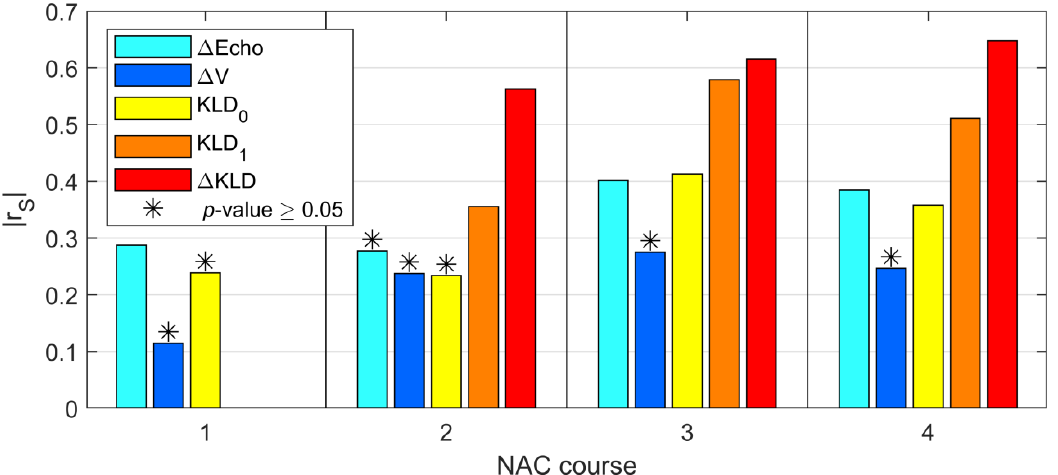
Figure 7. Correlation values for the five analyzed parameters ( ∆ Echo, ∆ V, KLD 0 , KLD 1 , and ∆ KLD) as a function of chemotherapy courses. Statistical insignificance ( p -value ≥ 0.05) marked with asterisks.